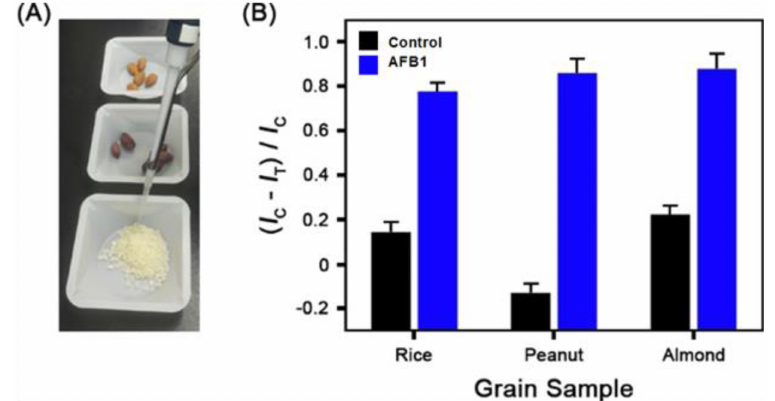
Figure 5. ( A ) Photograph of the AFB1-spiked rice, peanut, and almond samples. ( B ) Plot of ( I C − I T )/ I C versus the grain sample. The blue bars were obtained from the AFB1-spiked grain samples, and the black bars from pure grain samples. I C and I T represent the mean SPR response intensity in the control and test channels, respectively.